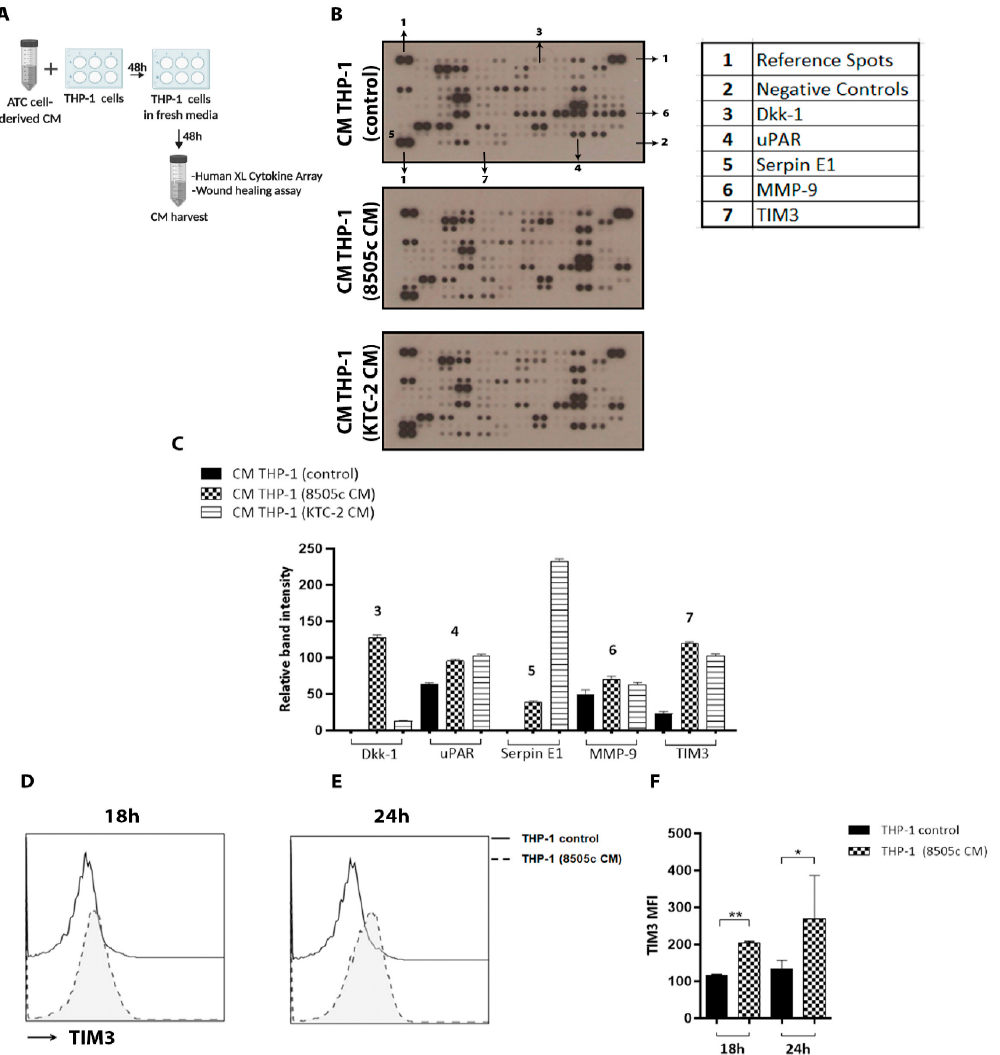
Figure 4. Cytokine array analysis revealed high TIM3 expression on M2-like macrophage-derived CM. ( A ) Schematic representation of CM preparation from THP-1 cells. Complete media containing 5% FBS or 100% CM from 8505c and KTC-2 cells were used for the treatment of THP-1 cells for 48 h. The medium was discarded and then incubated with fresh medium. After 48 h, 100% CM from THP-1 cells were collected and analyzed by the Proteome Profiler Human XL Cytokine Array Kit. ( B ) Cytokine array profiling of CM derived from THP-1 cells. Antibodies for detection of each cytokine were spotted in duplicate. Reference spots and negative controls had six and two spots each, respectively. ( C ) Densitometric analysis revealed that TIM3 was consistently high in both CM THP-1 (8505c CM) and CM THP-1 (KTC-2). ( D ) TIM3 expression was verified by flow cytometry analysis. THP-1 cells treated with 8505c-derived CM for 18 h ( D ) and 24 h ( E ) compared to THP-1 control (incubated with complete media containing 5% FBS). Representative histograms ( D – E ) and quantification ( F ) are shown. Data are expressed as mean ± SD. * p < 0.05, ** p < 0.005. Created with BioRender.